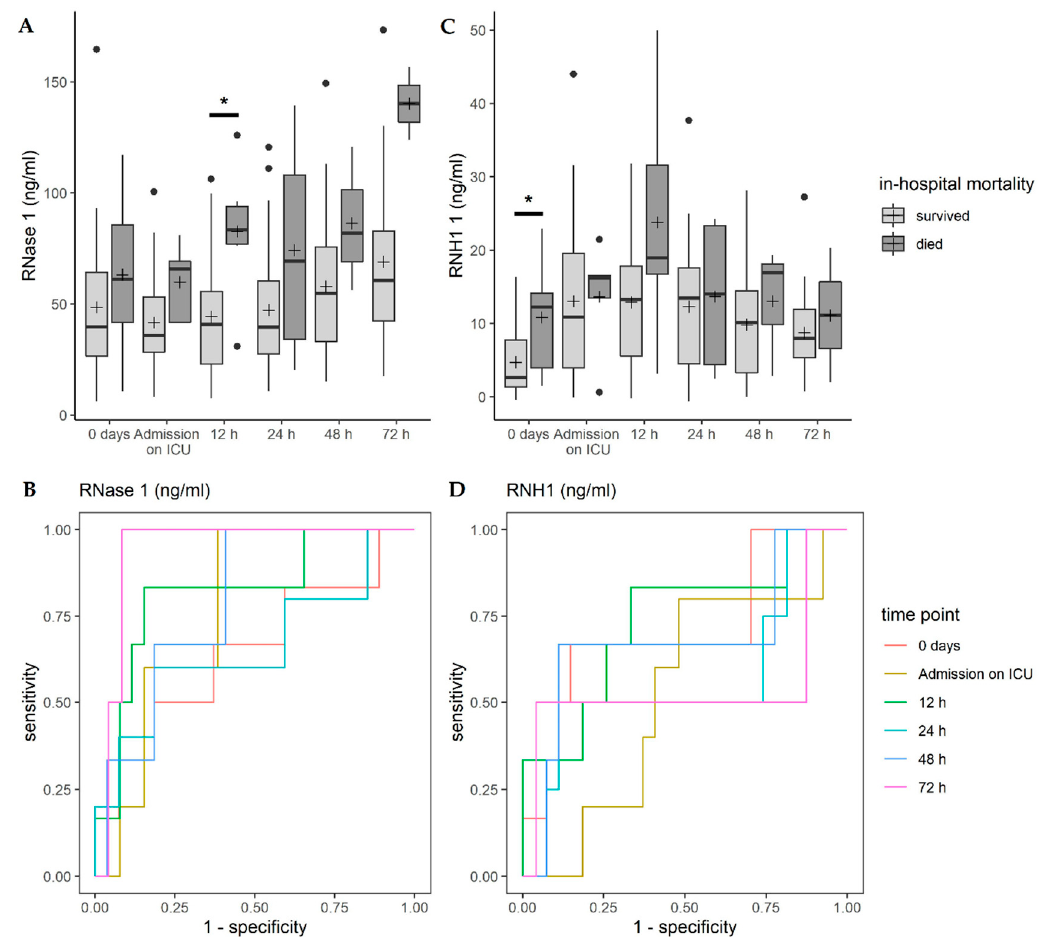
Figure 5. The correlation of ( A ) RNase 1 and ( C ) RNH1 with in-hospital mortality. Data are presented as box-whisker plots. Lines inside the boxes represent the median and the pluses represent the mean. The box is defined by Q1 and Q3. The whiskers range from Q1 to Q1 + 1.5 ∗ (Q3 − Q1) and Q3 to Q3 − 1.5 ∗ (Q3 − Q1), with observations outside of the whiskers shown as points classified as outliers. ROC analysis of the diagnostic accuracy of ( B ) RNase 1 and ( D ) RNH1 serum levels for in-hospital mortality in patients undergoing endovascular or open TAAA repair. * p < 0.05; RNase, ribonuclease; RNH1, RNase inhibitor 1 .